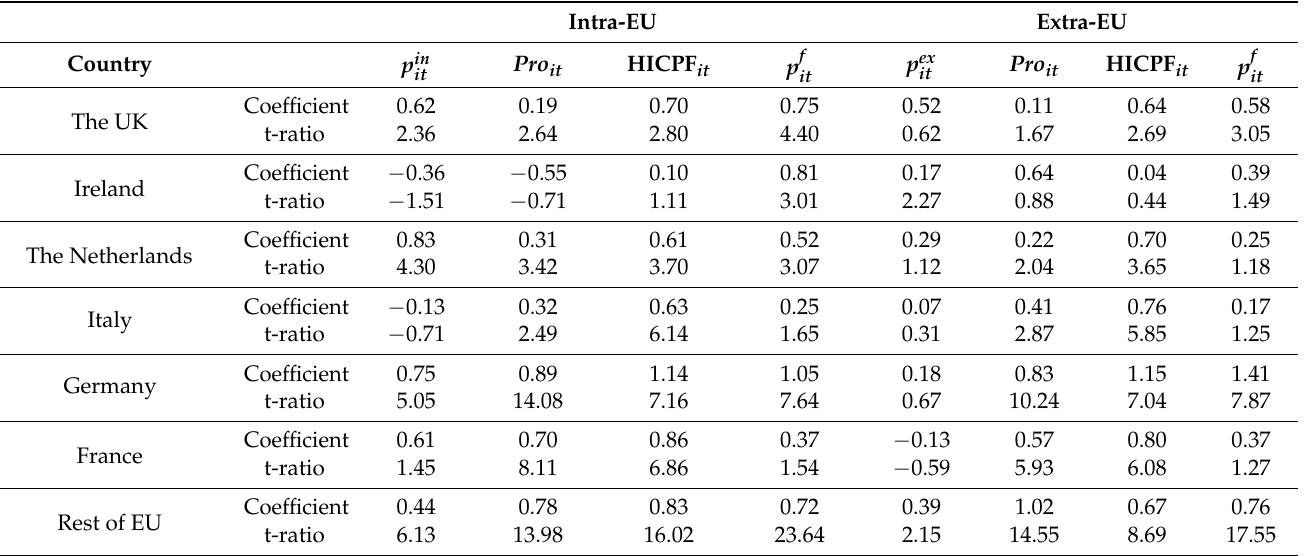
Table 5. Contemporaneous effects of foreign variables on domestic counterparts of intra-EU and extra-EU